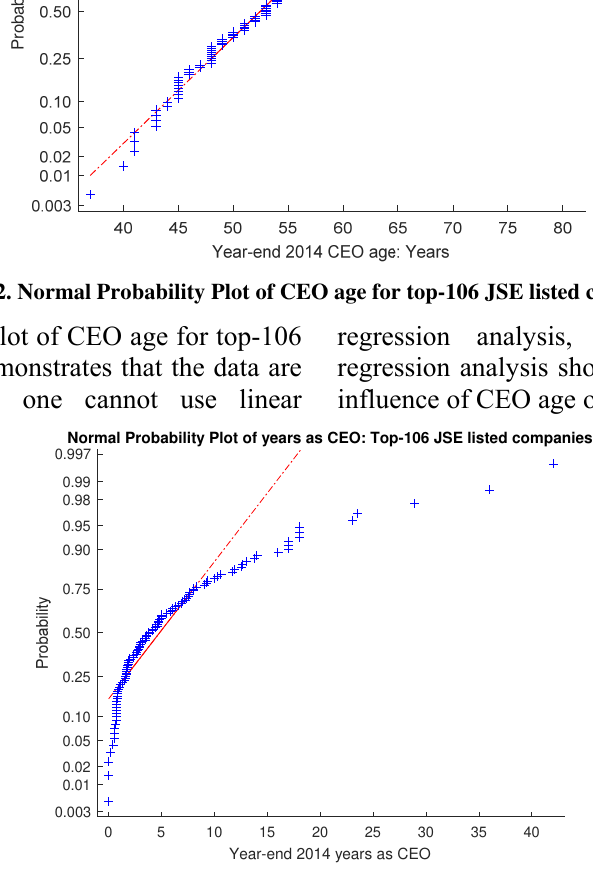
Fig. 3. Normal Probability Plot of years as CEO for top-106 JSE listed